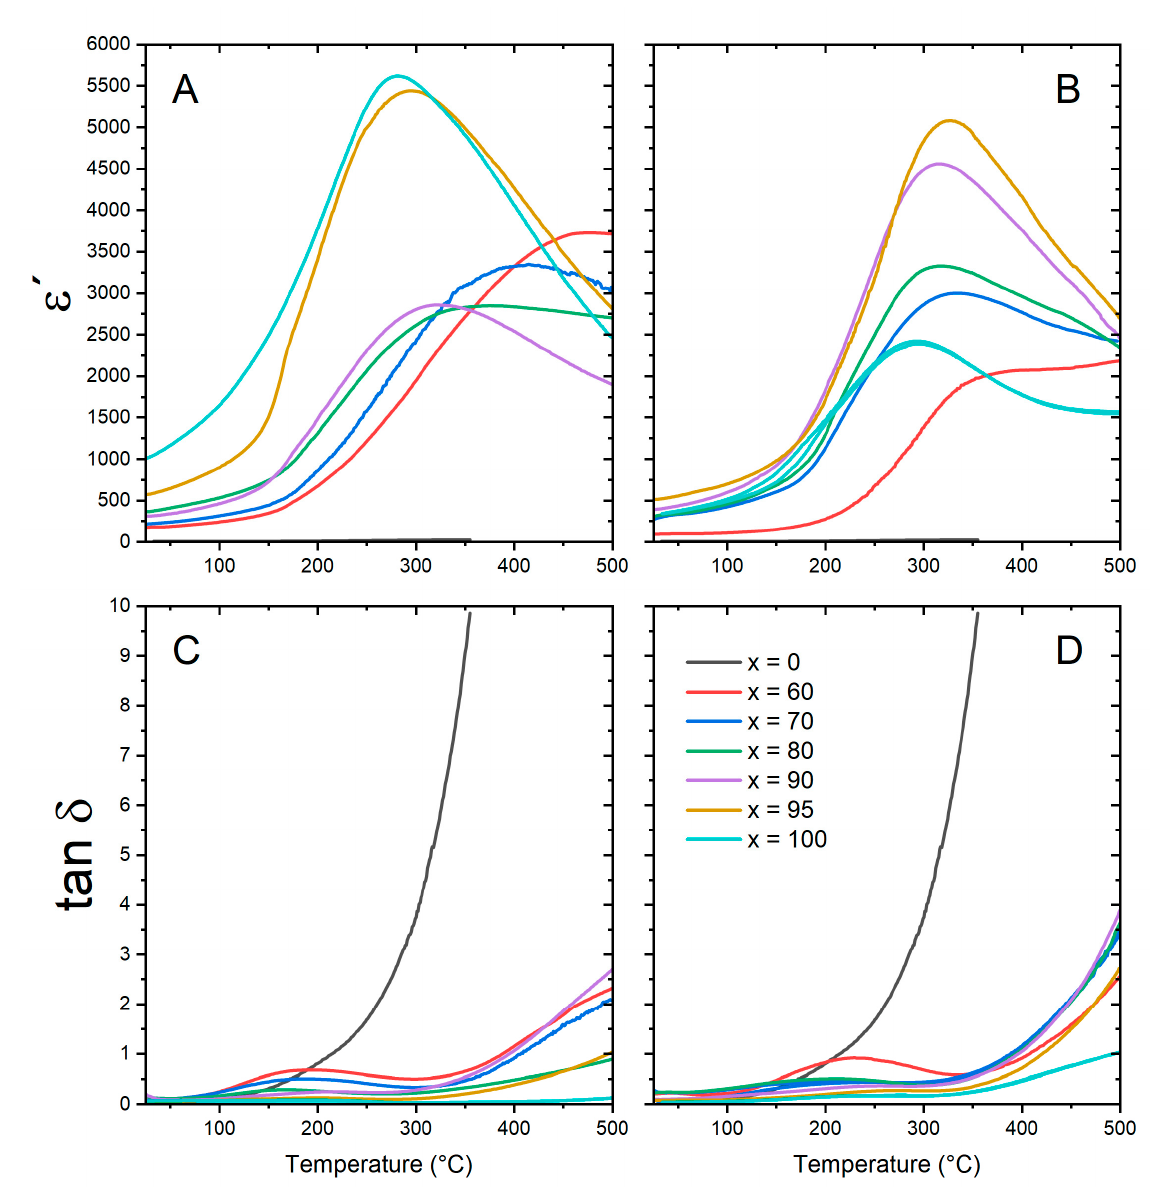
Figure 7. Real permittivity ( ε′ ) and loss tangent (tan δ ) vs. temperature curves for BNKT, NCF, and BNKT-NCF sintered samples obtained by the different methods at 1 MHz. SS-PE ( A , C ) and SG-PE ( B , D ).